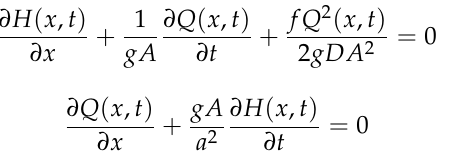
Figure 2. Comprehensive characteristic curves of the turbine.